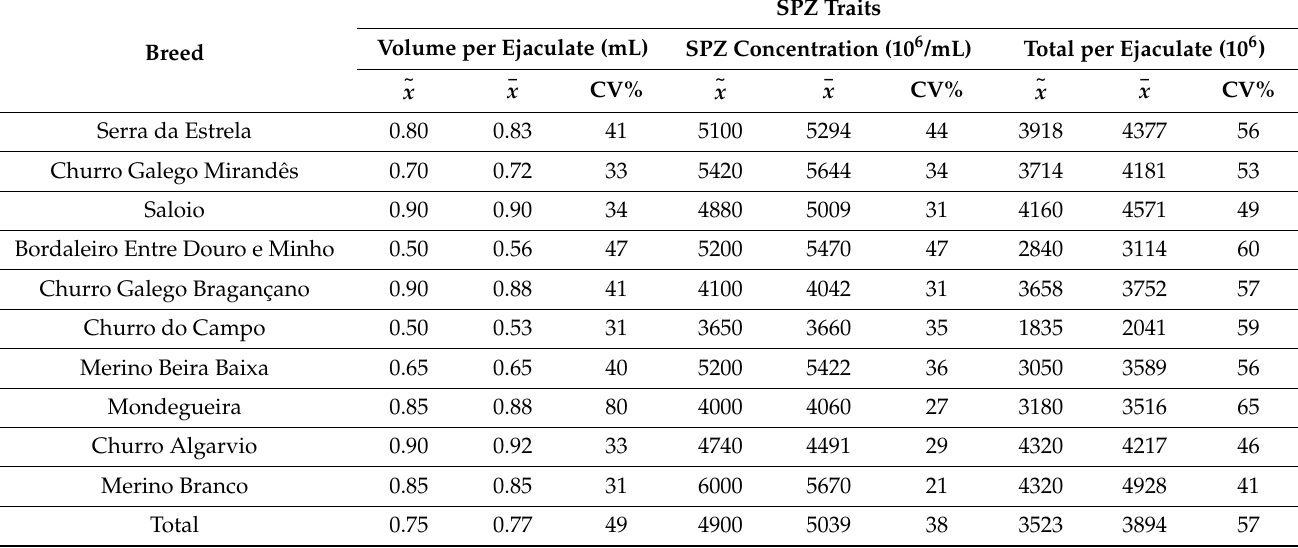
Table 2. Descriptive statistics of ejaculate traits for each